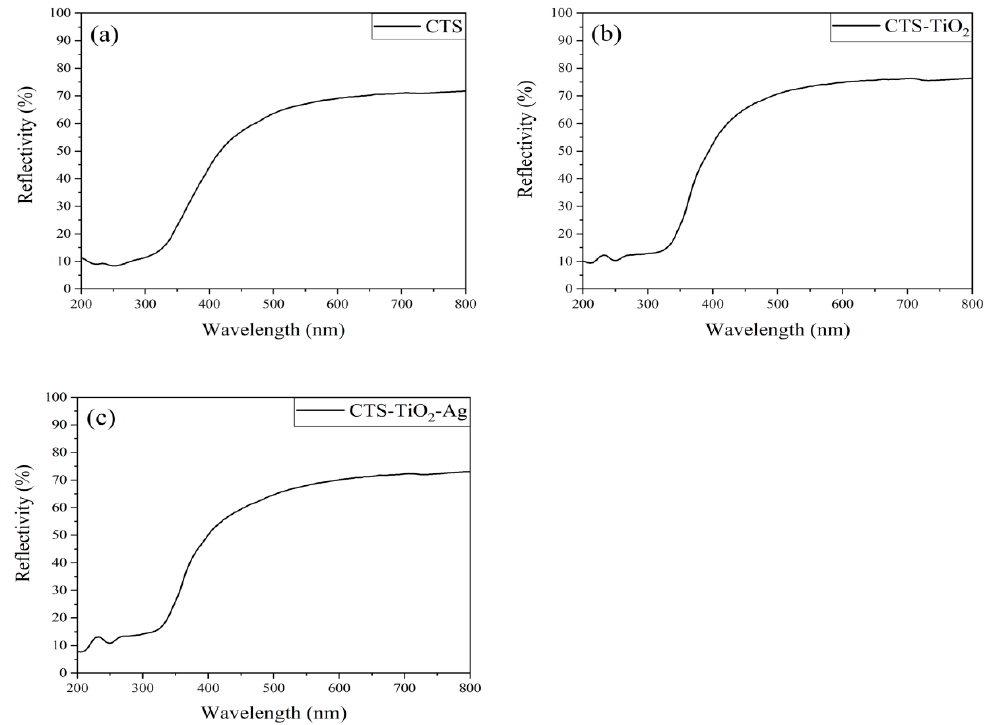
Figure 2. The reflectivity of the three films: ( a ) CTS single membrane; ( b ) CTS-TiO 2 composite membrane; ( c ) CTS-TiO 2 -Ag composite membrane.